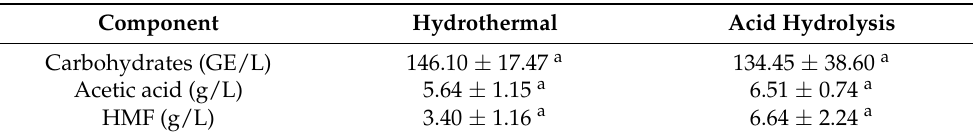
Table 6. Initial composition of the hydrolysates before fermentation. Pretreatment conditions: T = 130 ◦ C, 1 h. Component Hydrothermal Carbohydrates